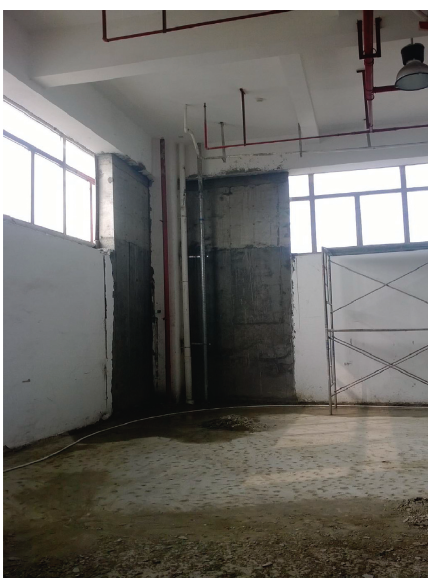
Figure 1: Photo of a short-pier shear wall.